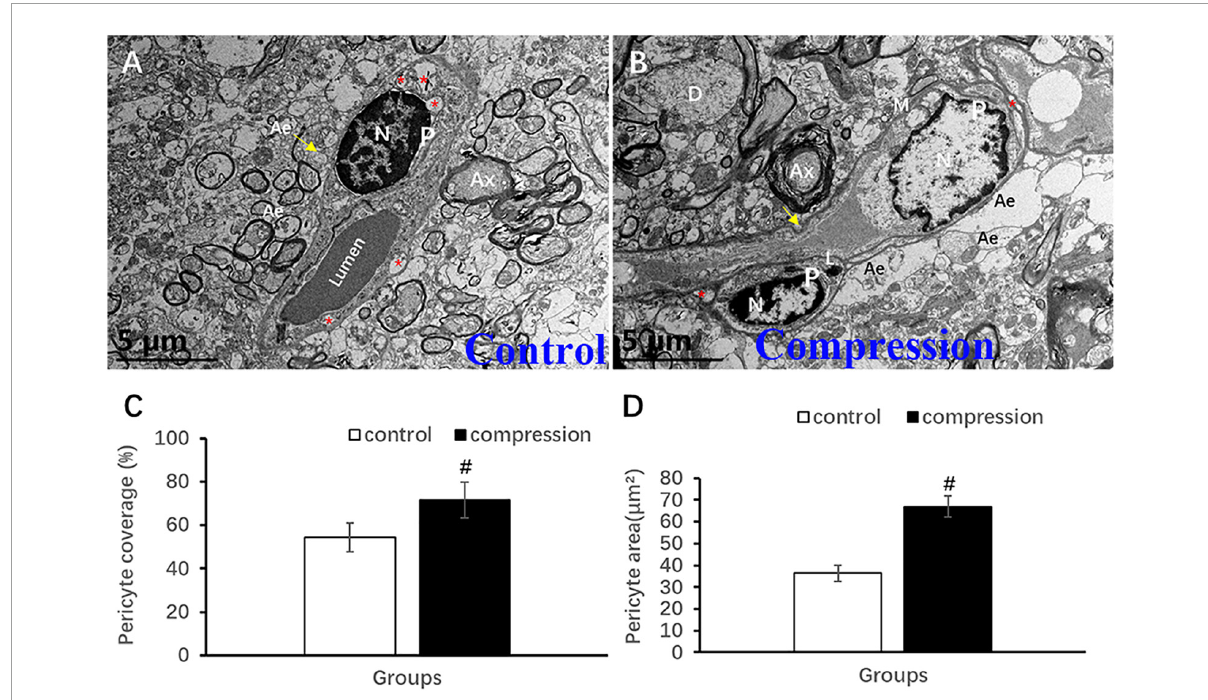
FIGURE9 Ultrastructural evidence of pericytes degeneration. (A) Control group. (B) CSM group. Comparison of pericyte vascular coverage rate (C) and pericytes area (D) . N, nucleus; P, pericyte; Ax, axon; Ae, astrocyte endfeet; D, dendrite; “*” indicates caveolae. # P < 0.05 compared with the control group, n = 6 per